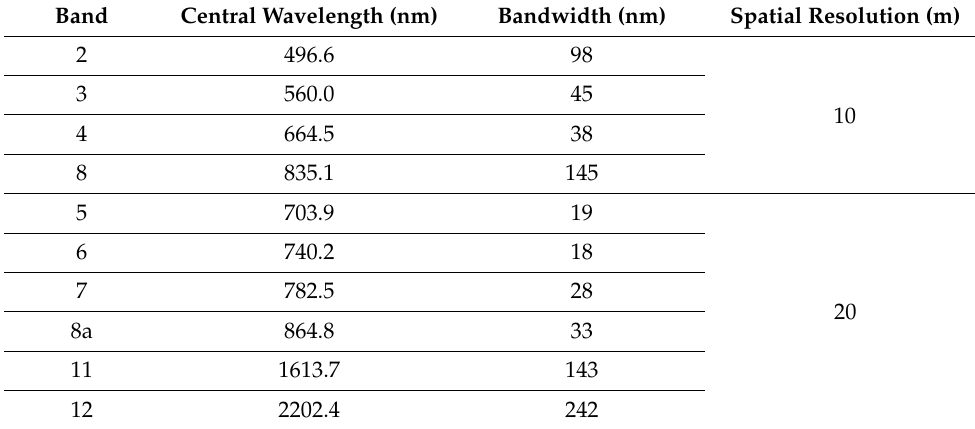
Figure 2. Spectra of raw samples acquired by spectroradiometer and spectral resolution of Sentinel-2A bands. Table 1. Details of Sentinel-2A bands used in the research.